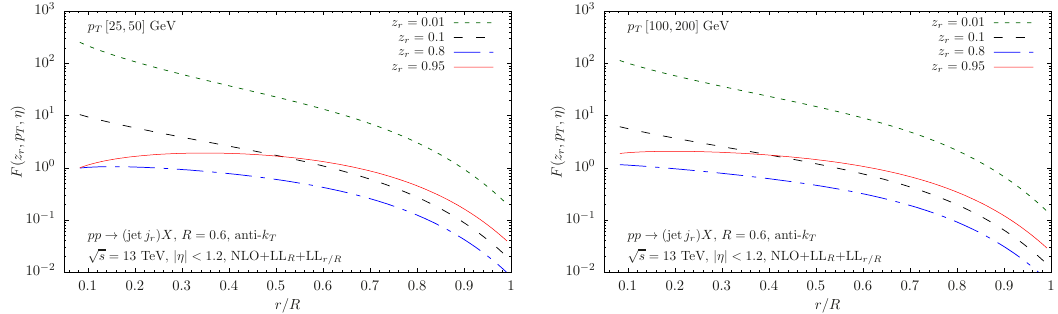
Figure 7 . The subjet distribution measured on inclusive jets as a function of r=R , using the same kinematics as in (cid:12)gures 5 and 6, and the jet p T bin [25 ; 50] GeV (left) and [100 ; 200] GeV (right). Four representative values of the ratio z r are shown: 0.01 (green dotted), 0.1 (black dashed), 0.8 (blue dot-dashed) and 0.95 (red